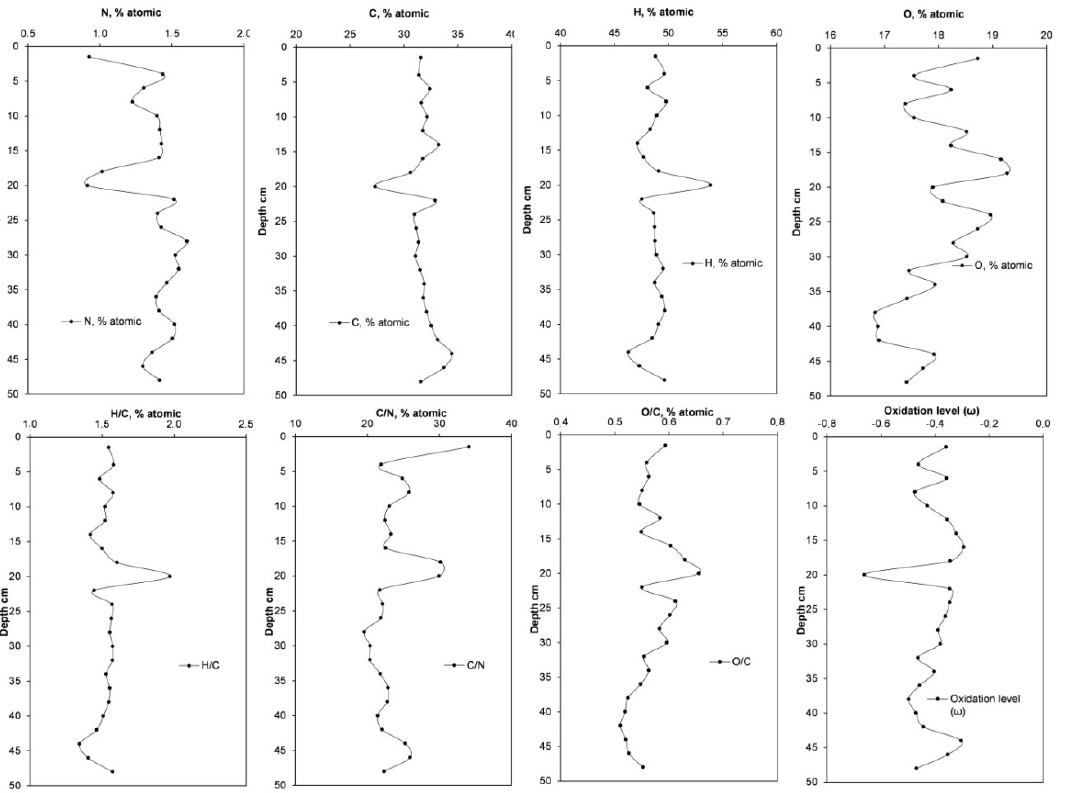
Figure 2. Change in the elemental composition of peat profile by